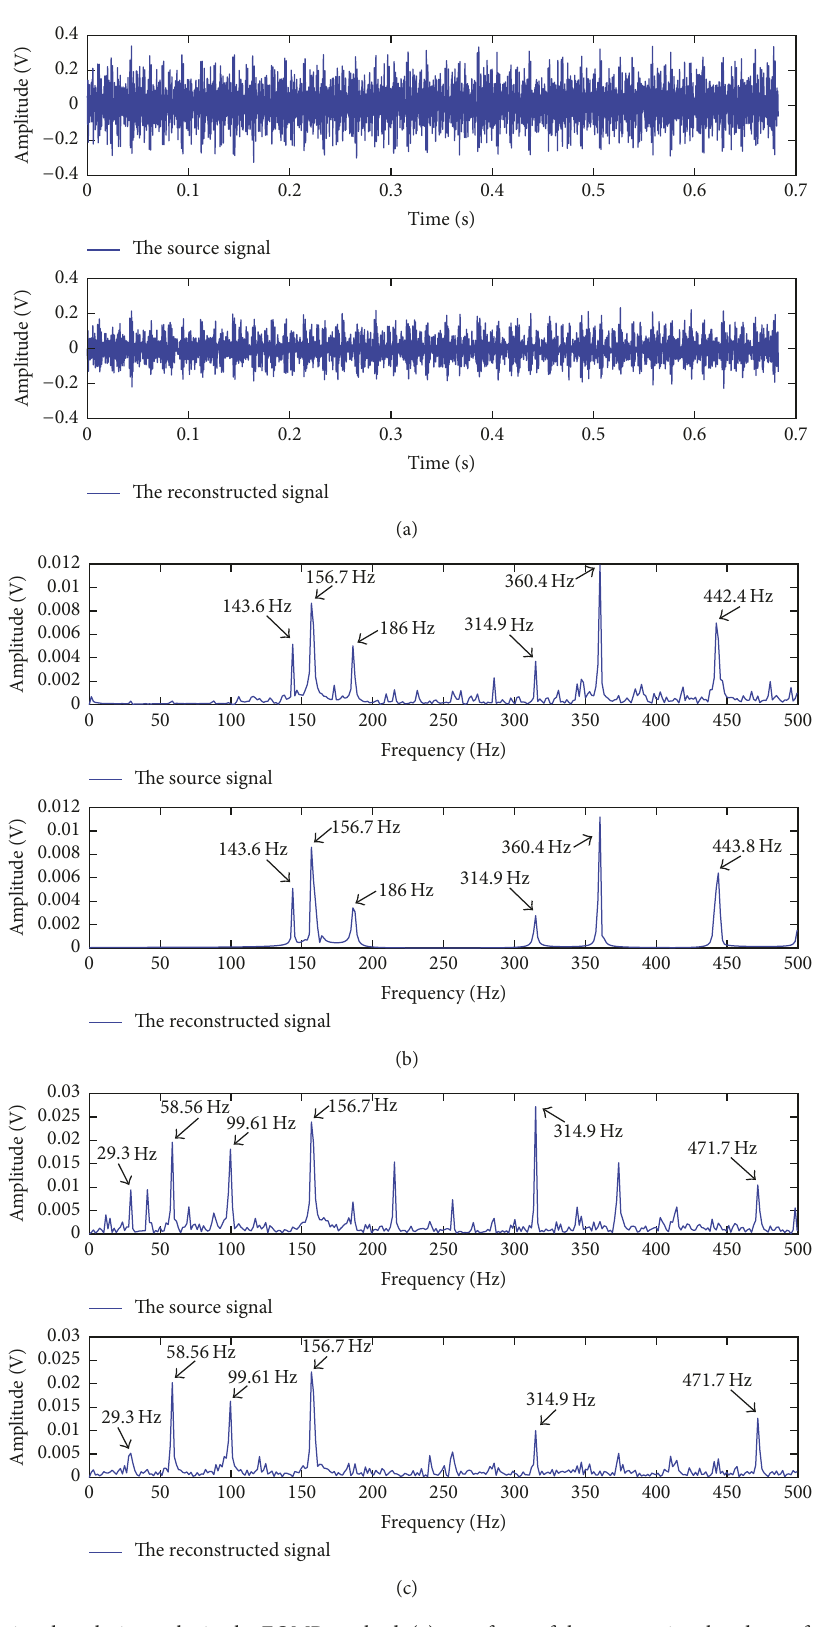
Figure 7: Bearing fault signal analysis results in the EOMP method: (a) waveform of the source signal and waveform of the reconstructed signal, (b) FFT spectrum of the source signal and FFT spectrum of the reconstructed signal, and (c) Hilbert spectrum of the source signal and Hilbert spectrum of the reconstructed